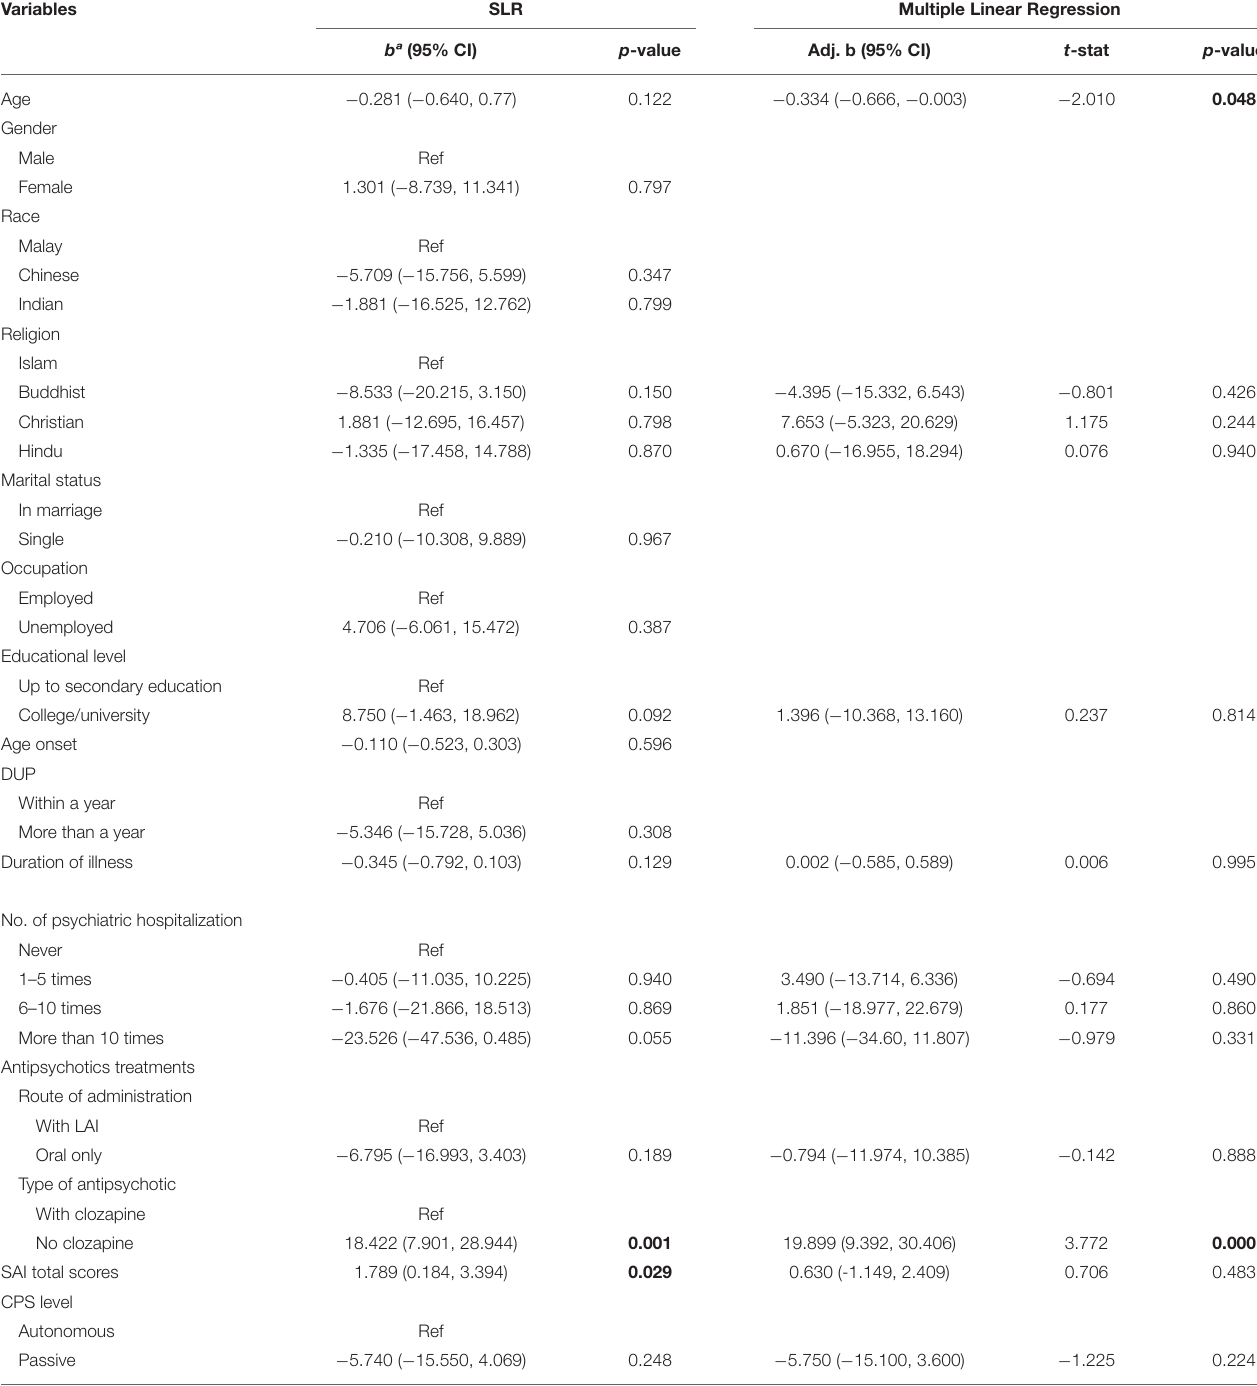
TABLE 3 | Factors associated with SDM using SLR and multiple linear regression.